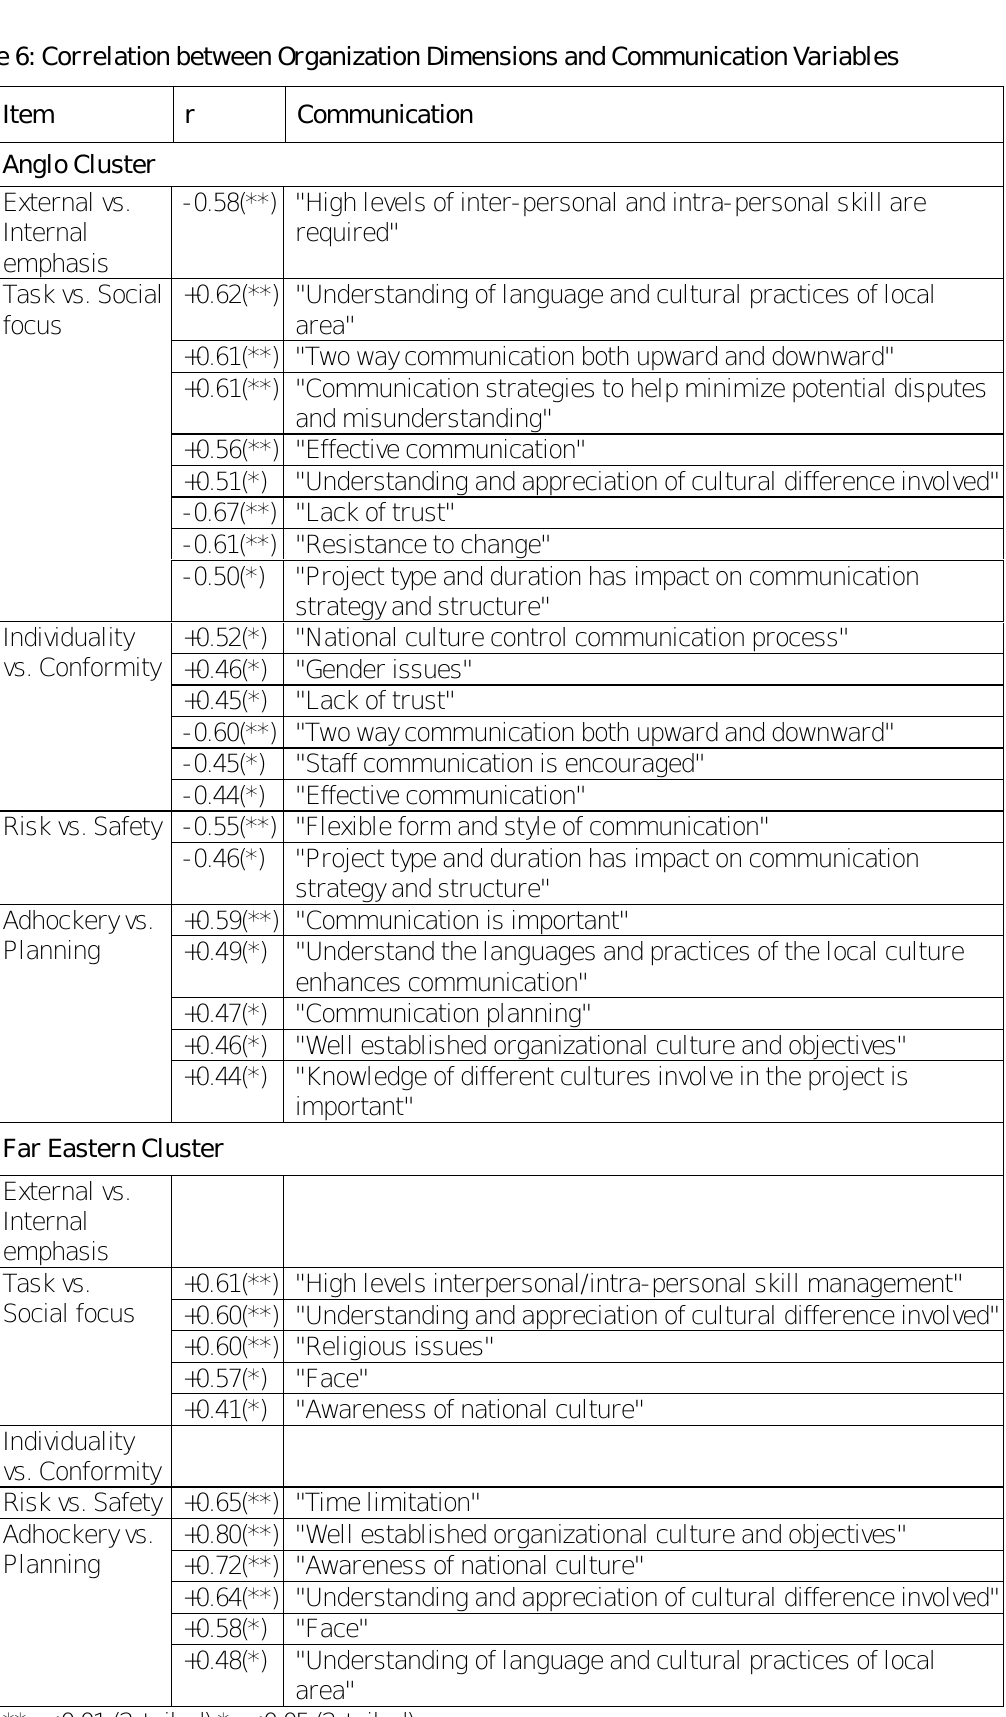
Table 6: Correlation between Organization Dimensions and Communication Variables Item r Communication Anglo Cluster External